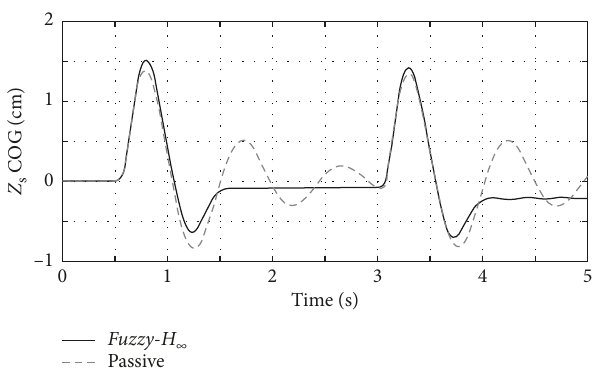
Figure 9: COG chassis